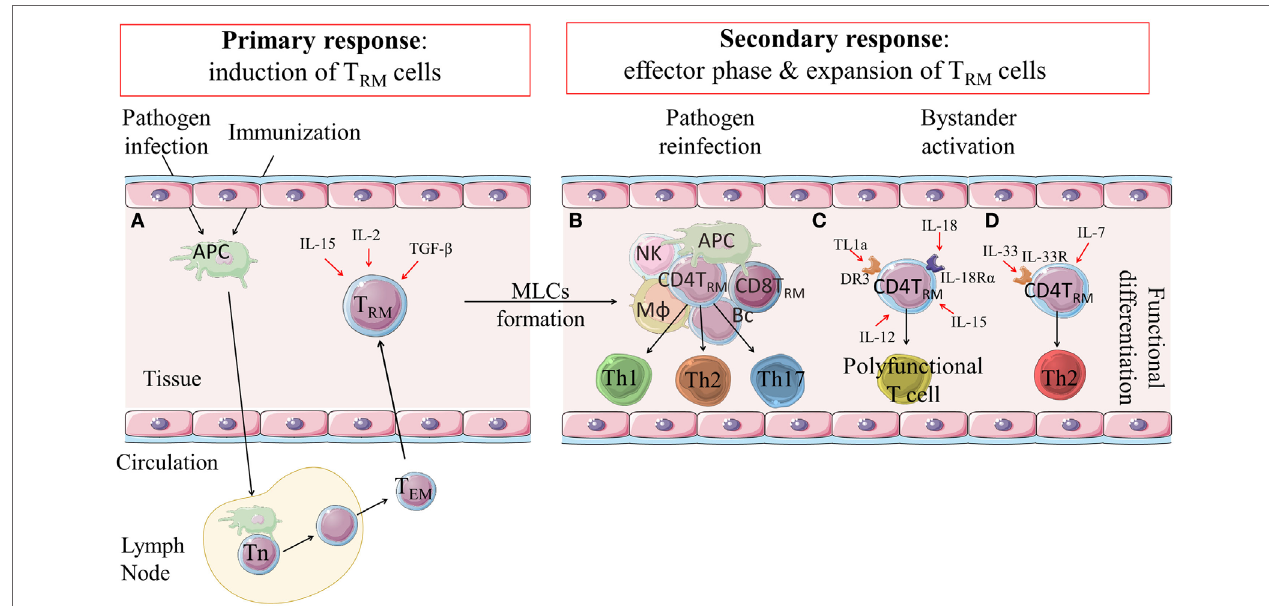
FigURe 1 | Induction, expansion and function of CD4 T RM cells. (A) Following infection or immunization effector and memory T cell responses are induced in lymph nodes. Effector-memory T cells can migrate to the tissue where they are retained as CD4 T RM cells through expression of integrins and adhesion molecules, such as CD44, CD69 and/or CD103. Their induction is influenced by IL-2, IL-15 and TGF- β . (B) CD4 T RM cells are retained in the tissues and can be reactivated locally in MLCs during secondary responses following reinfection or after infection in an immunized host. CD4 T RM cells are expanded and can become effector Th1, Th17 or Th2-type cells that mediate rapid clearance of the infection. (C) There is emerging evidence that CD4 T RM cells can be non-specifically activated in the tissues by cytokines, such as IL-18, IL-12, IL-15 and TL1a, and develop into polyfunctional T cells that have potent anti-pathogen activity. (D) It has also been suggested that IL-7 and IL-33 may non-specifically activate CD4 T RM cells to become effector Th2 cells. DR3: death receptor 3; TL1a: tumor necrosis factor (TNF)-like cytokine 1a; MLCs: memory lymphocyte clusters; APC: antigen presenting cell; M ϕ : macrophage; NK: natural killer cell; Bc: B cells; Th: T helper (cell); T n : naïve T cell; T EM : effector memory T cells; T RM : tissue-resident memory T